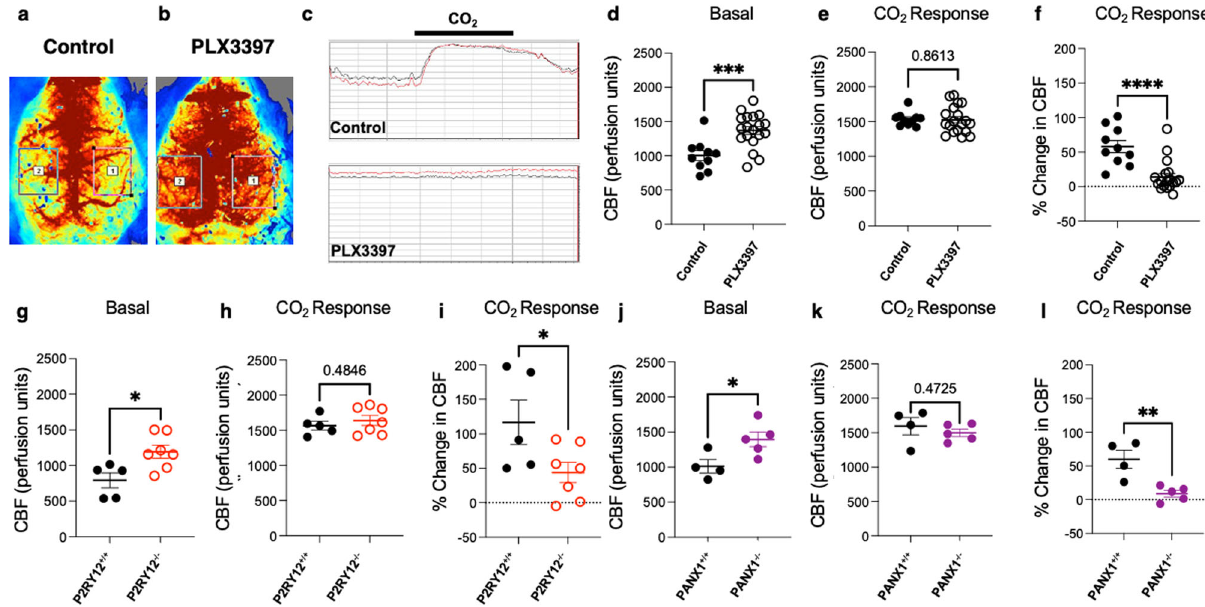
Fig. 7 Microglia regulate vascular function through PANX1 – P2RY12 coupling. a – c Representative laser speckle images ( a , b ) and graphical tracing ( c ) of cerebral blood fl ow in control and following PLX3397 treatment. d – f Quanti fi cation of basal cerebral blood fl ow ( d ), cerebral blood fl ow in response to CO 2 response ( e ), and the change in cerebral blood fl ow with CO 2 treatment ( f ) in control or PLX3397-treated conditions. n = 10 control and 19 PLX3397- treated mice. g – l Quanti fi cation of basal cerebral blood fl ow ( g , n = 5 – 7 mice each and j , n = 4 – 5 mice each) cerebral blood fl ow in response to CO 2 response ( h , n = 5 – 7 mice each and k , n = 4 – 5 mice each) and the change in cerebral blood fl ow with CO 2 treatment ( i , n = 5 – 7 mice each and l , n = 4 – 5 mice each) in P2RY12 + / + and P2RY12 − / − mice ( g – i ) and PANX1 + / + and PANX1 − / − mice ( j – l ) ( n = 4 – 7 mice each). Data are presented as